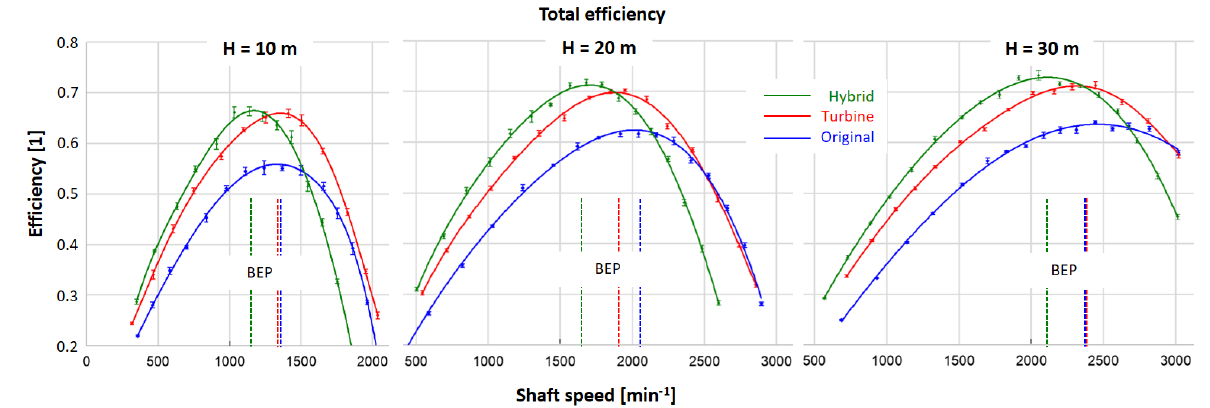
Figure 9. Efficiency in terms of dependence on shaft speed.